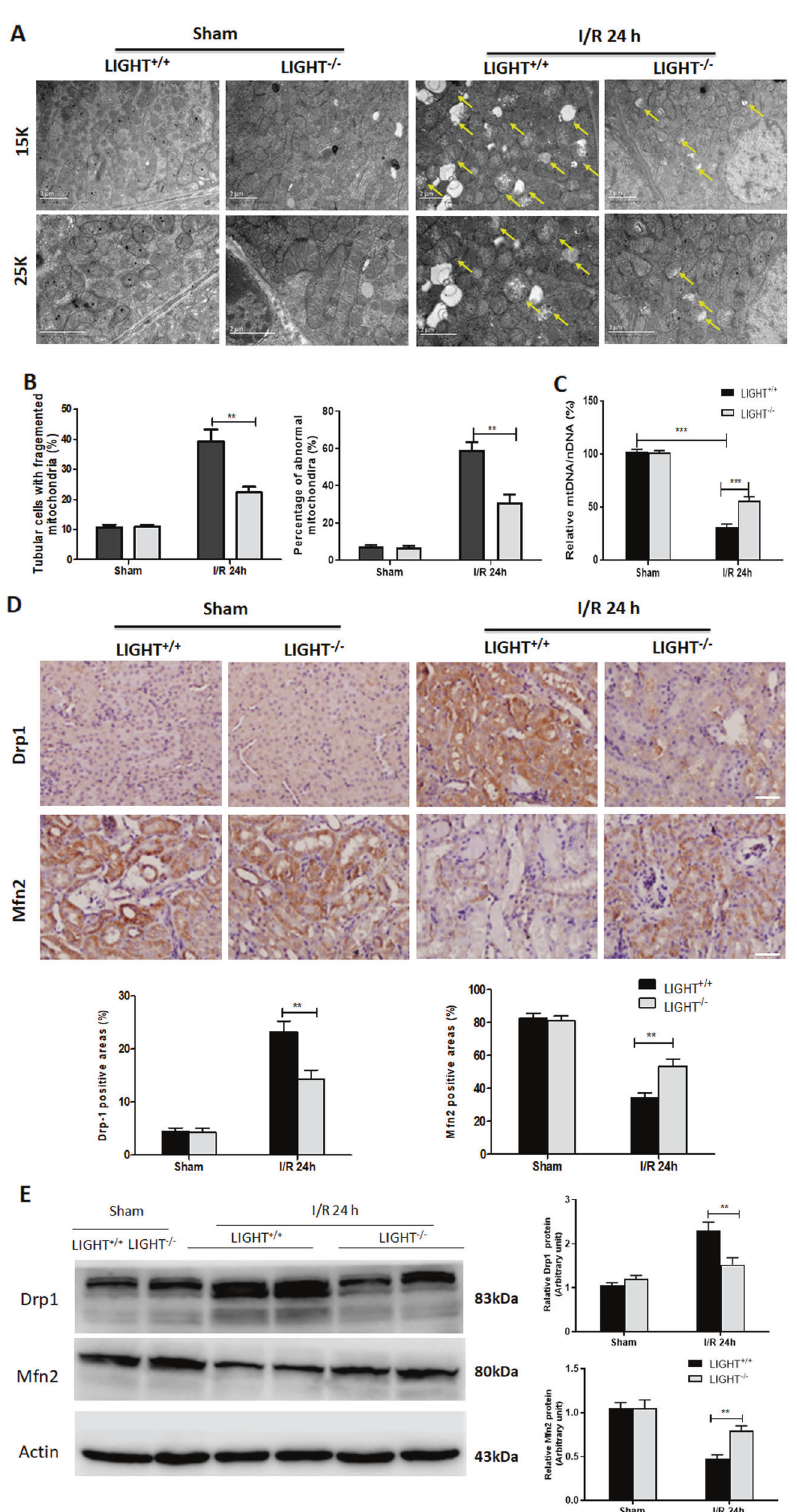
Fig. 5 LIGHT loss decreases mitochondrial fragmentation. Wild-type (LIGHT + / + ) and LIGHT (LIGHT − / − ) mice received renal ischemia or sham surgery followed by reperfusion for 24 h. A Representative TEM images of mitochondrial morphology. Yellow arrows indicate the injured mitochondria in tubular cells. Scale bars: 2 μ m. B Quanti fi cation of mitochondrial fragmentation and abnormal mitochondria detected by TEM. C Relative mitochondria DNA copy numbers (mtDNA/nDNA) assessed by qPCR. D IHC staining and quanti fi cation for the expression of Drp1 and Mfn2. Scale bar, 50 μ m. E Immunoblot analysis of Drp1, Mfn2, and actin (loading control) in the renal tissue. Right pane: quanti fi cation of Drp1 and Mfn2 expression. Results are shown as mean ± SEM. ( n = 6 – 8 for each group). Differences between the two groups were assessed with Student ’ s t test. * p < 0.05, ** p < 0.01; *** p < 0.001 vs. LIGHT + / + mice with I/R-AKI.